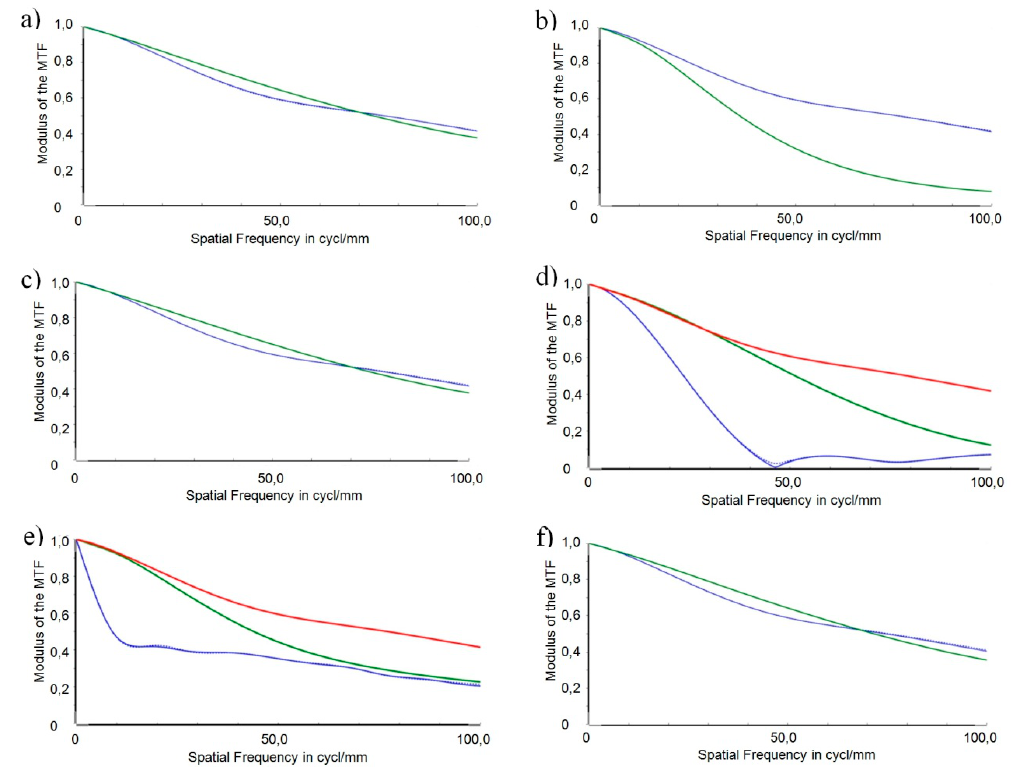
Figure 14. MTF for the different types of position tolerances identified and the robust design (green) in comparison with that of the original design as shown in Figure 12 (blue), and the MTF of the error-free configuration (red). ( a ) Decentration in x ; ( b ) Decentration in y ; ( c ) Decentration in z ; ( d ) Lateral position error; ( e ) Wedge error; ( f ) Orientation error.